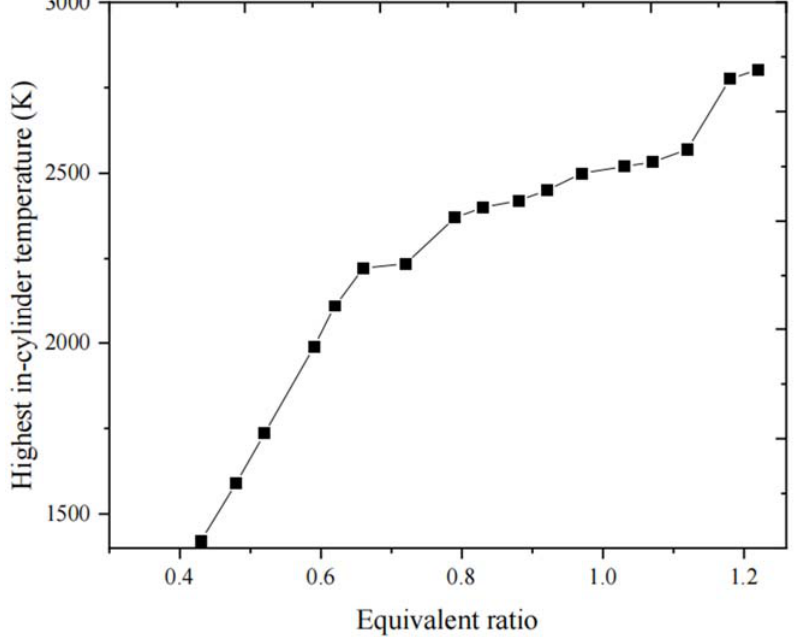
Figure 16. Highest mean in-cylinder temperature with equivalent ratio.